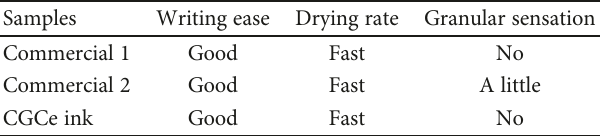
Table 6: Writing activity test of di ff erent